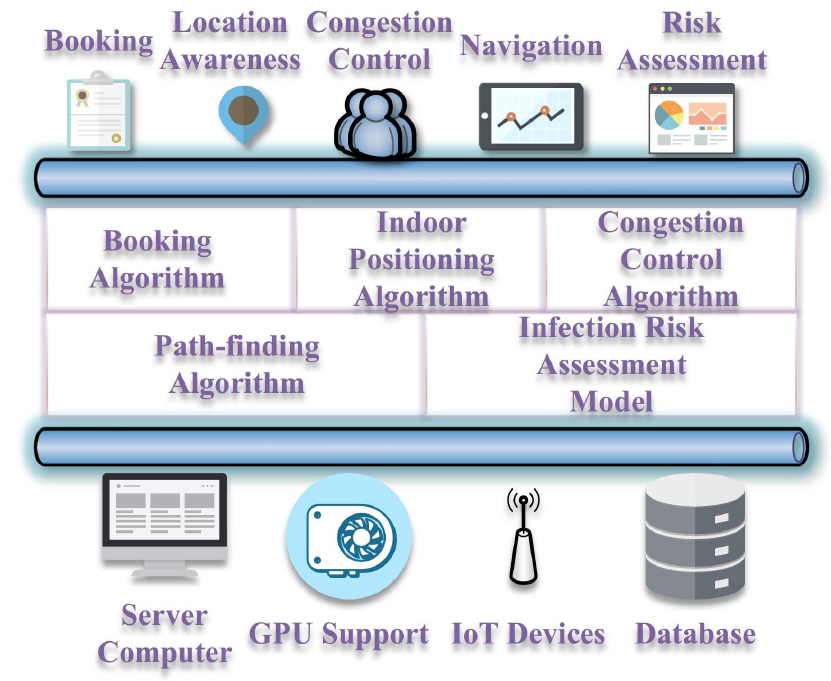
Figure 1. The structure of the system.